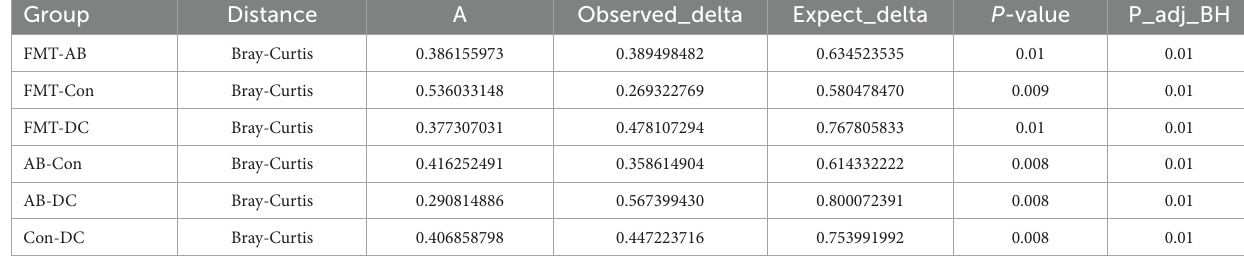
TABLE 2 The multi-response permutation procedures difference analysis of the four groups. Group